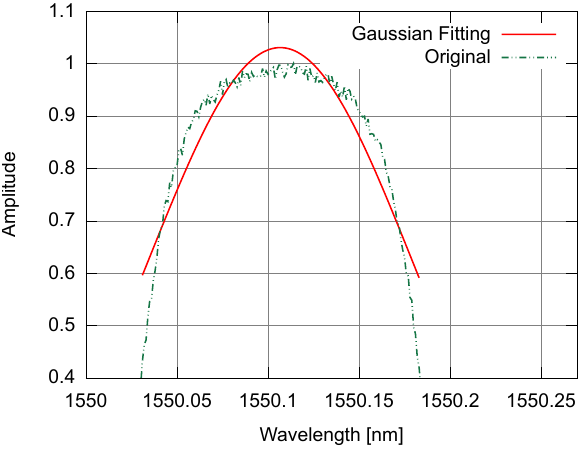
Figure 5. Example of gaussian fitting for a spectrum from an FBG with uniform modulation index profile.